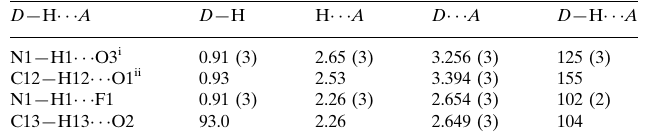
Hydrogen-bond geometry (A˚ , (cid:1)